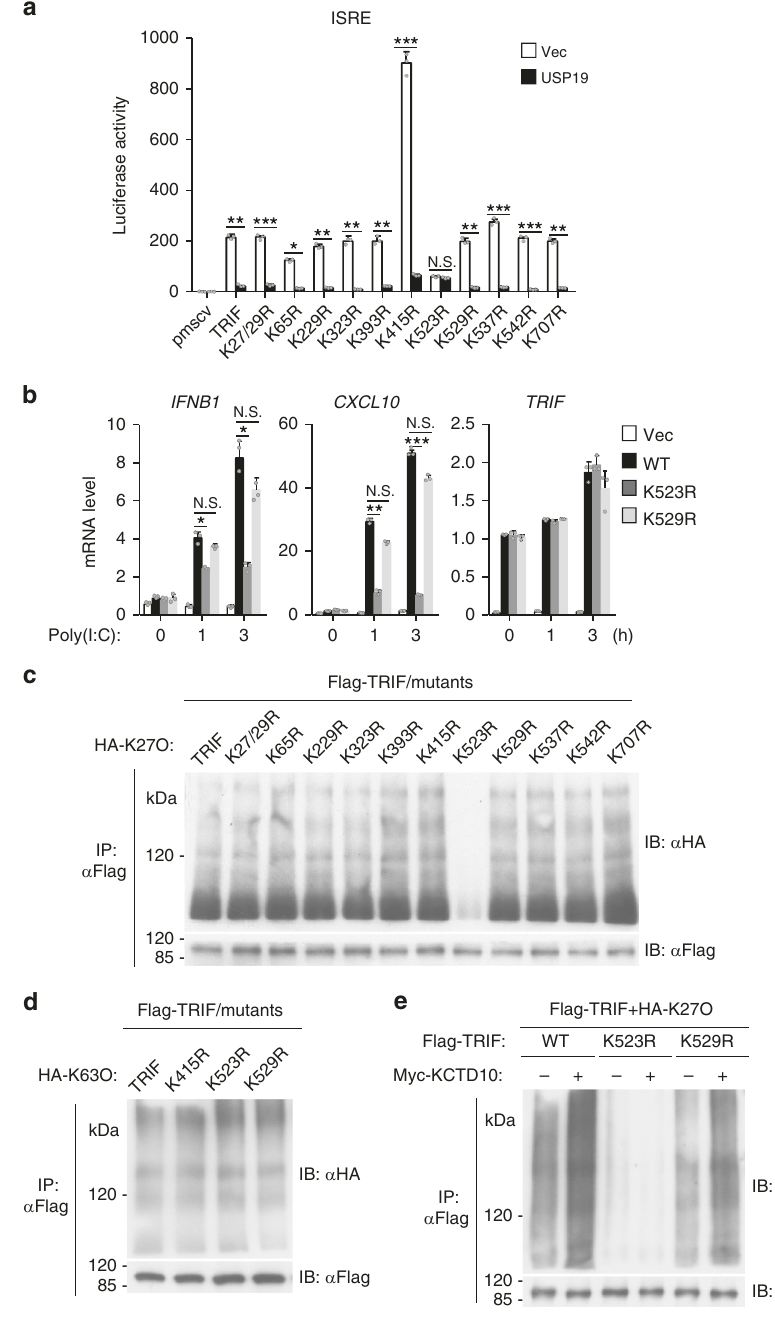
Fig. 8 K523 of TRIF is modi fi ed by K27-linked polyubiquitination. a Effects of USP19 on ISRE activation induced by wild-type (WT) and mutant TRIF. HEK293 cells were transfected with ISRE reporter and WT or mutant TRIF expression plasmids together with a control or USP19 expression plasmid for 20 h before reporter assays were performed. Graphs show mean ± SD; n = 3 independent samples in a , b . * P < 0.05, ** P < 0.01, *** P < 0.001 (one-way ANOVA followed by Dunnett ’ s test). N.S., not signi fi cant. b Effects of TRIF and its mutants on poly(I:C)-induced transcription of downstream genes. TRIF- de fi cient 293-TLR3 cells reconstituted with TRIF or its mutants were treated with poly(I:C) or left untreated for the indicated times before qPCR analysis. Graphs show mean ± SD; n = 3 independent samples in a , b . * P < 0.05, ** P < 0.01, *** P < 0.001 (one-way ANOVA followed by Turkey ’ s test). N.S., not signi fi cant. c Effects of mutation of various lysine residues of TRIF on its K27-linked polyubiquitination. Flag-tagged TRIF or its mutants were individually transfected into HEK293 cells along with HA-ubiquitin (K27O). Twenty hours after transfection, ubiquitination assays were performed with the indicated antibodies. d Effects of mutation of various lysine residues of TRIF on its K63-linked polyubiquitination. Flag-tagged TRIF or its mutants were transfected into HEK293 cells together with HA-ubiquitin (K63O). The experiments were performed similarly as c . e Effects of KCTD10 on K27-linked polyubiquitination of WT and mutant TRIF. The experiments were performed similarly as c . Data are representative of two or three experiments with similar results. Source data are provided as a Source Data fi le. Error bars represent standard deviation of the